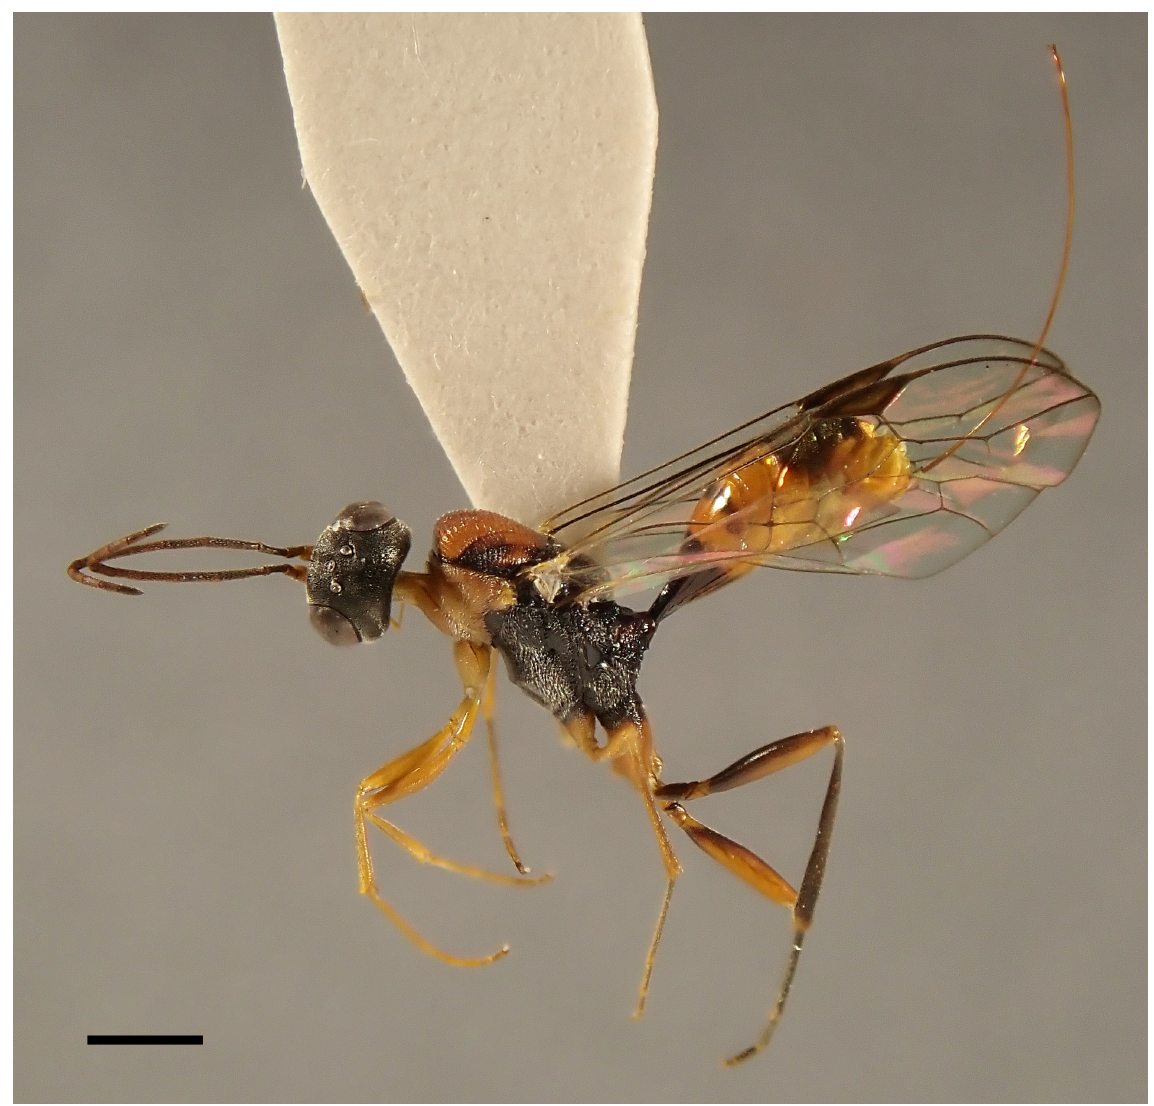
Fig. 2. Aulacus burwelli Jennings, Austin & Stevens, 2004, ♀ (MNHN), lateral habitus. Scale bar =